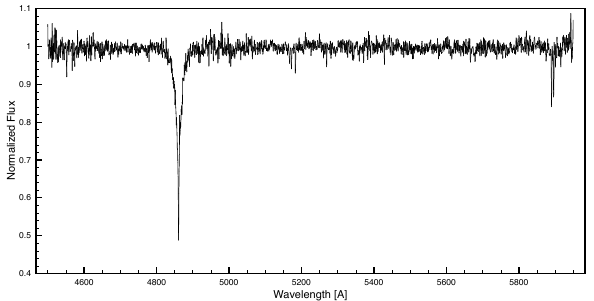
Figure 1. Portion of a MagE spectrum of M5865.